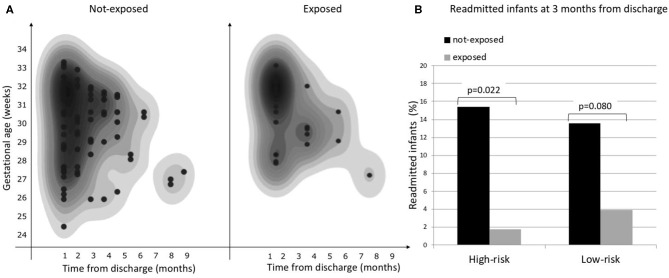
(A) Overall risk of hospital readmission by gestational age and time from discharge, (B) Proportion of hospital readmissions during the first 3 months from discharge in exposed and not-exposed infants in high- and low-risk groups.